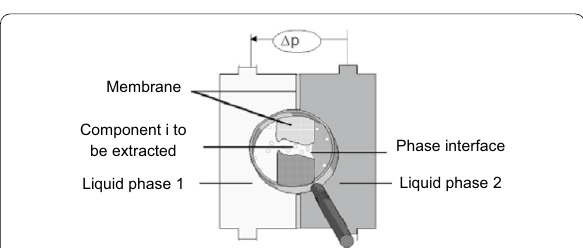
Fig. 1 Schematic diagram of ( a ) laboratory ATPS and ( b ) ATPS bioreactor